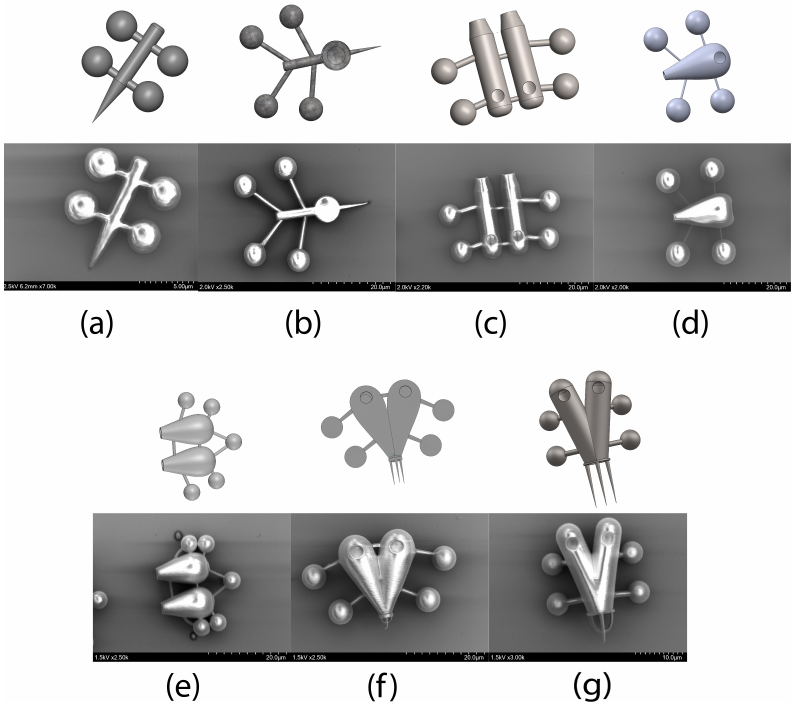
Figure 4. Fabricated microbots along with the 3D models followed by the SEM images ( a ) a simple microbot with four control handles and a spike at the front to poke cells or any object of interest, ( b ) a microbot equipped with a heating disk and a front poking mechanism, ( c ) microbot with a double channel with double opening design (straight), ( d ) microbot with single channel design, ( e ) double channel with double opening design (teardrop curve), ( f ) double channel with single opening design and spikes at the front (teardrop curve), and ( g ) double channel with single opening design and spikes at the front